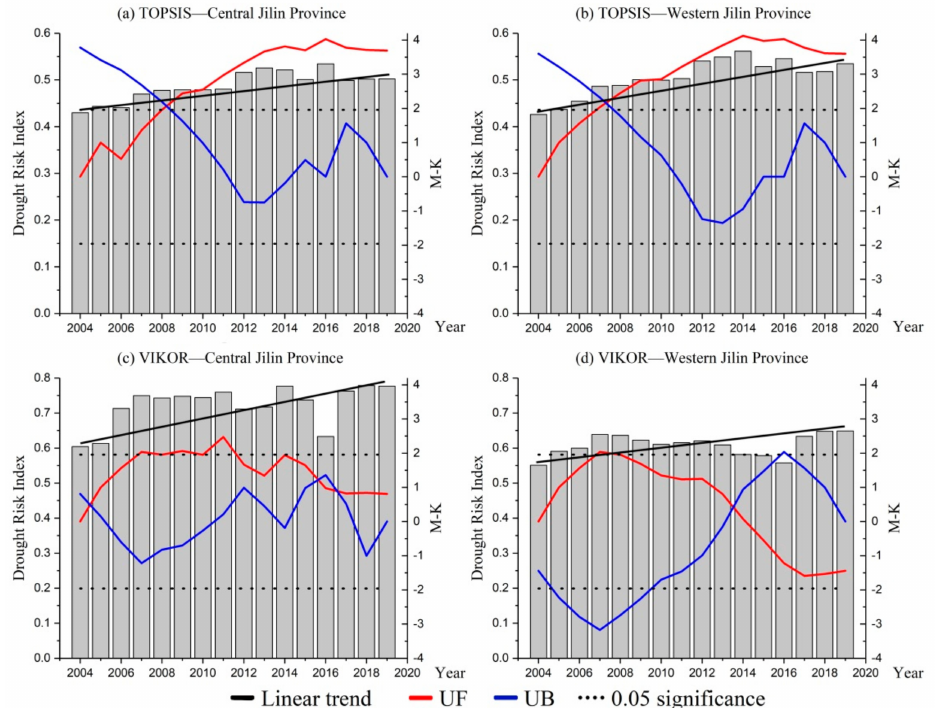
Figure 5. Change in drought risk index and M − K test for maize in midwestern Jilin